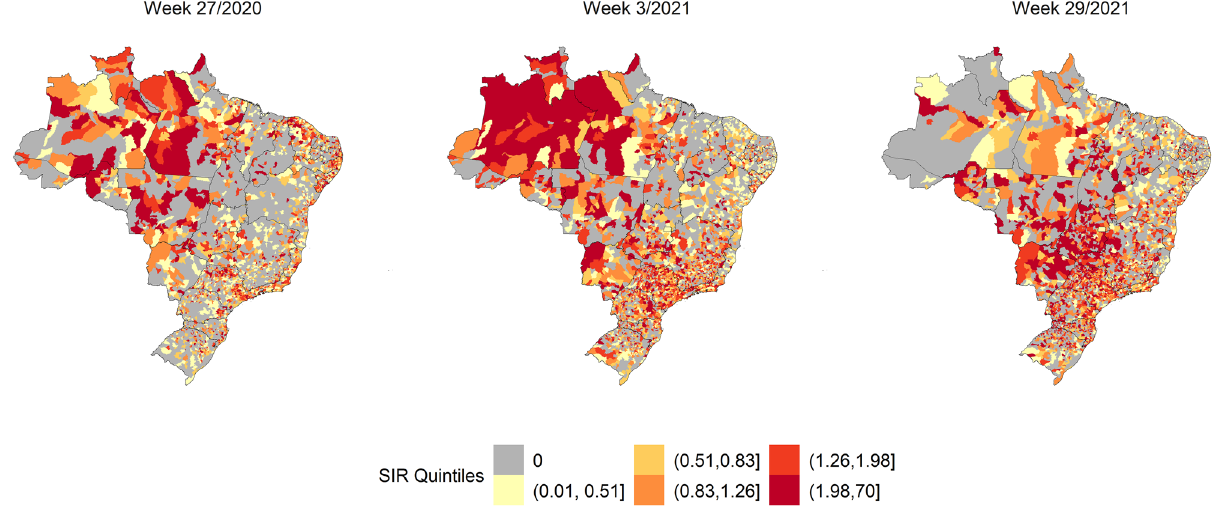
Figure 1. SIR Quintiles by Brazilian municipalities in weeks 27/2020, 3/2021, and 25/2021. The map was generated using public domain shapefiles provided by the Brazilian Institute of Geography and Statistics (https:// geoftp. ibge. gov. br/ organ izacao_ do_ terri torio/ malhas_ terri toria is/ malhas_ munic ipais/ munic ipio_ 2021/ Brasil/ BR/ BR_ Munic ipios_ 2021. zip). The figure was generated by the authors using the R 4.0.5 software 9 and the packages ggplot2 10 , sf 11 and tidyverse 12 .